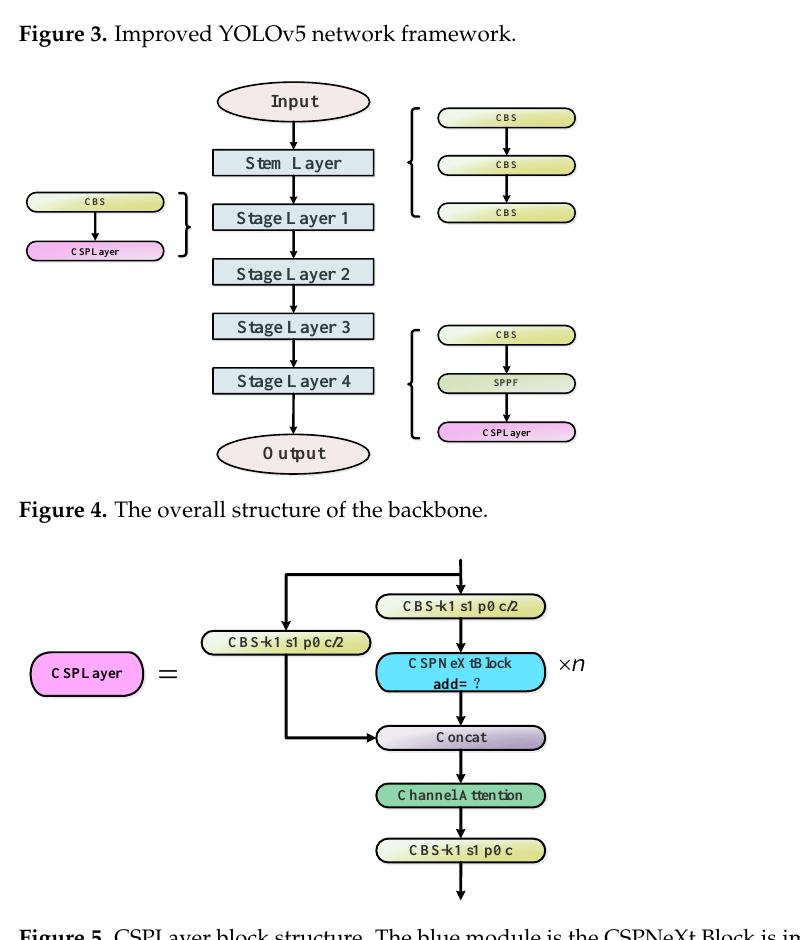
Figure 5. CSPLayer block structure. The blue module is the CSPNeXt Block is improved by introduc- ing a large convolution